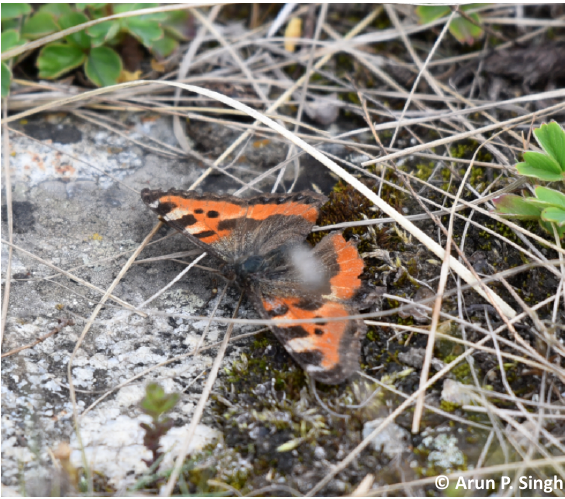
Image 6. Mountain Tortoiseshell Aglais rizana (Moore, 1872) photographed between Badrinath-Mana Village (3,151m), Chamoli District, Uttarakhand, India